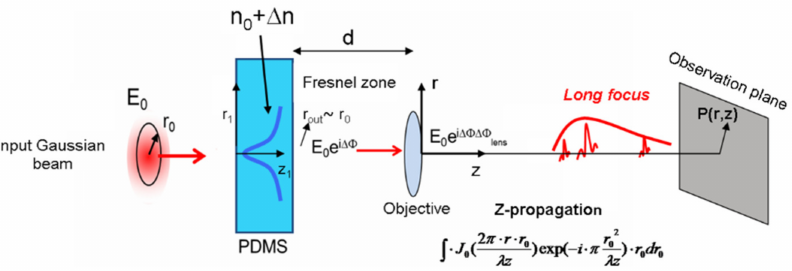
Figure 4. Propagation of the electromagnetic field through the optical chain. The input field E 0 acquires two phase delays, ∆Φ and ∆Φ lens , due to the refractive index gradient in the PDMS and the lens, respectively. The objective is located at distance d from the sample of about 15 mm. The beam is finally transformed into a long focusing range beam. See text for further